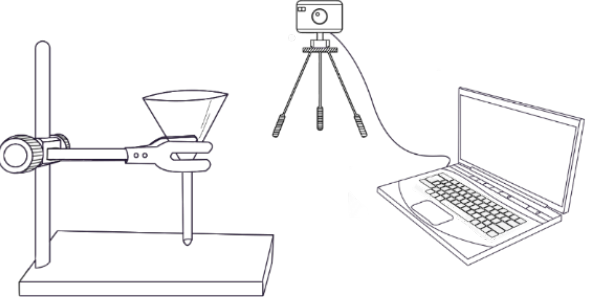
Figure 3. Angle of repose meter.